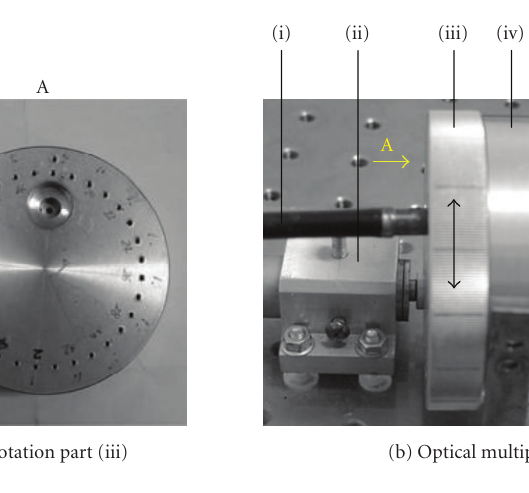
Figure 3: Optical multiplexer. For details, see the text.